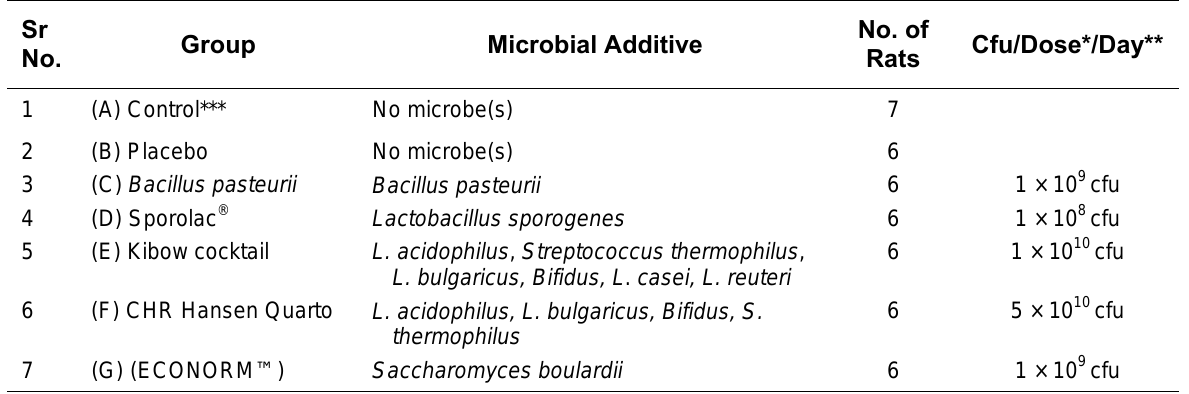
Composition of Microbial Additive, Fed to Different